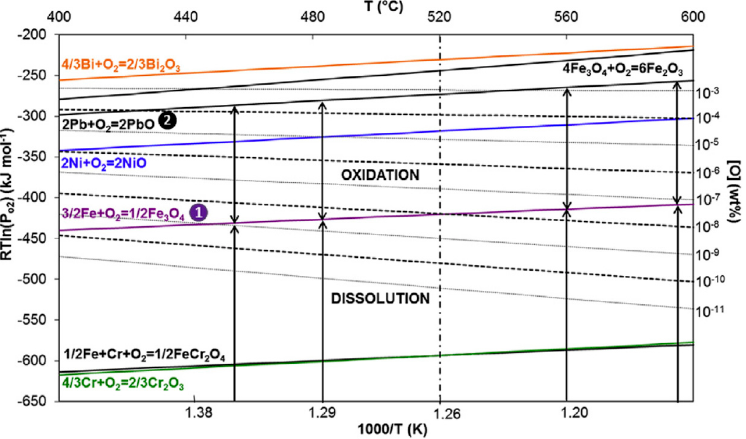
Figure 1. Ellingham diagram for the 316L alloy (i.e., element activities are equal to the molar fractions of the elements in the 316L alloy) in Lead–Bismuth Eutectic (LBE) from [21]. In saturated oxygen lead or LBE, the mechanism of corrosion is oxidation for both families of steels. Oxidation kinetics and mechanisms are now well documented for 316L stainless steels and for T91 martensitic steel in the range of 450–500 °C [20,22–24]. Oxidation kinetics is parabolic with an oxidation rate lower for 316L steel than for T91 steel. The oxide layer exhibits a duplex scale, consisting of an inner spinel and an outer magnetite. The layer thickness grows faster for the magnetite oxide than for the spinel oxide [25].